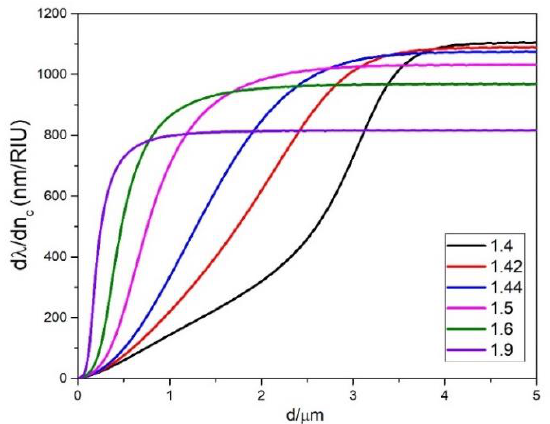
Figure 5. The dependence of ∂λ / ∂ n c on d for the p = 0 mode for selected values of n c for D = 150 μ m.